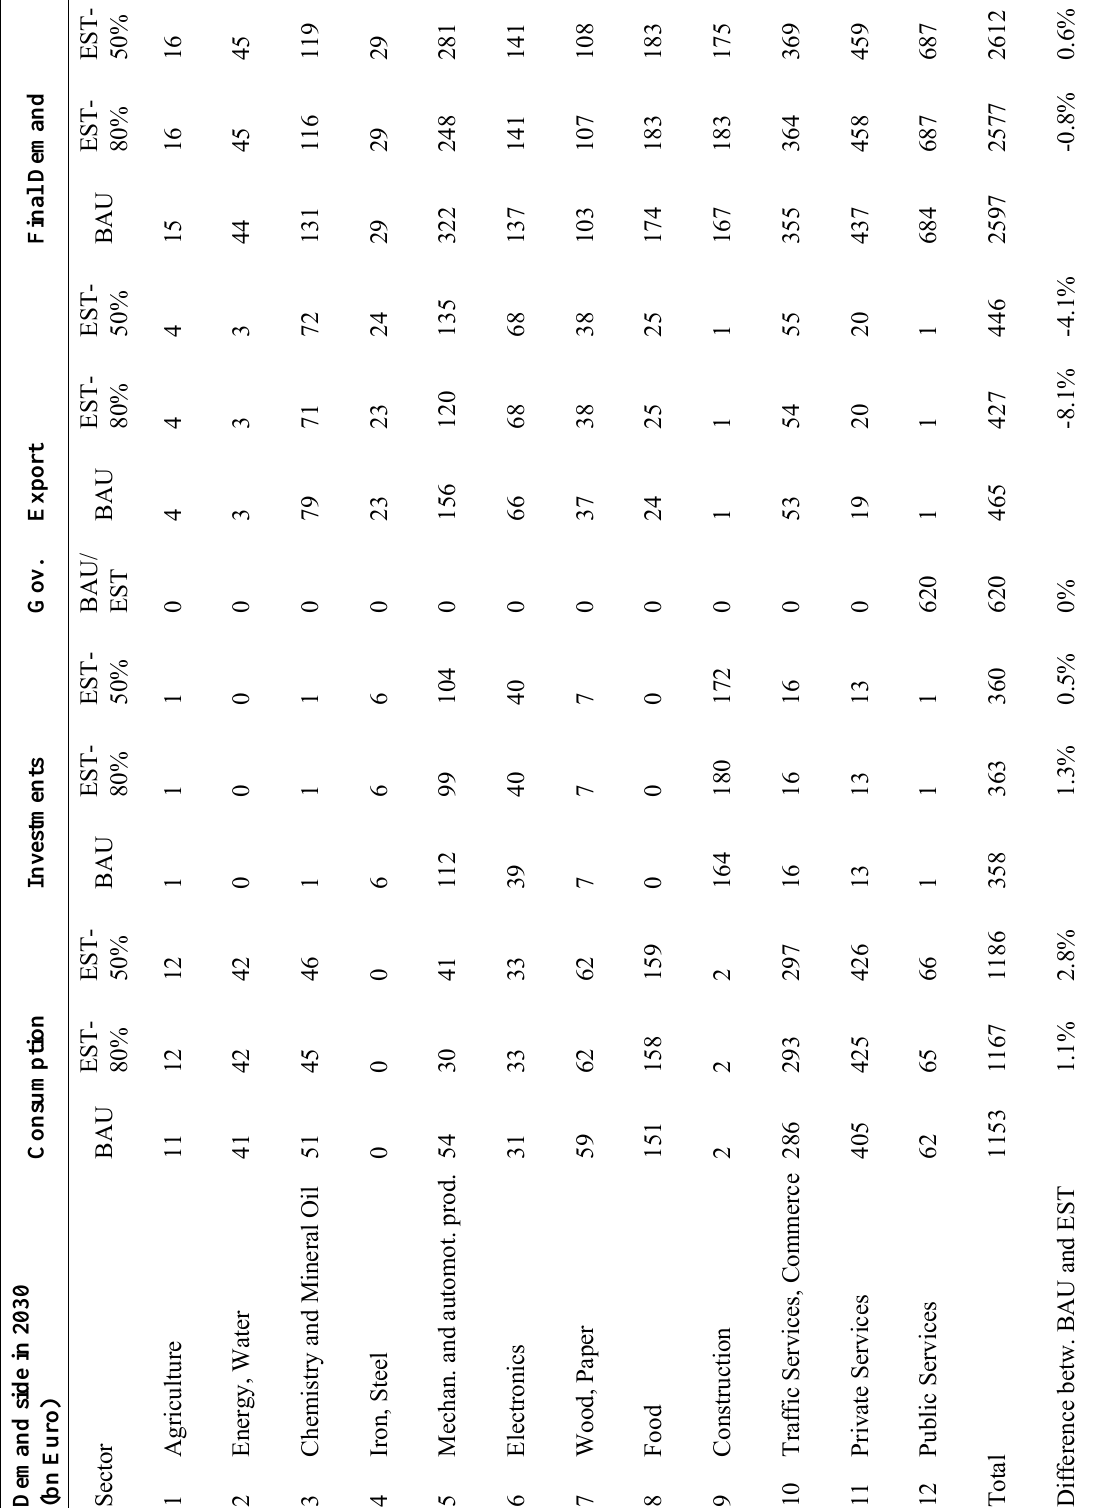
Table 3. Results of the Demand Side for EST-80% in